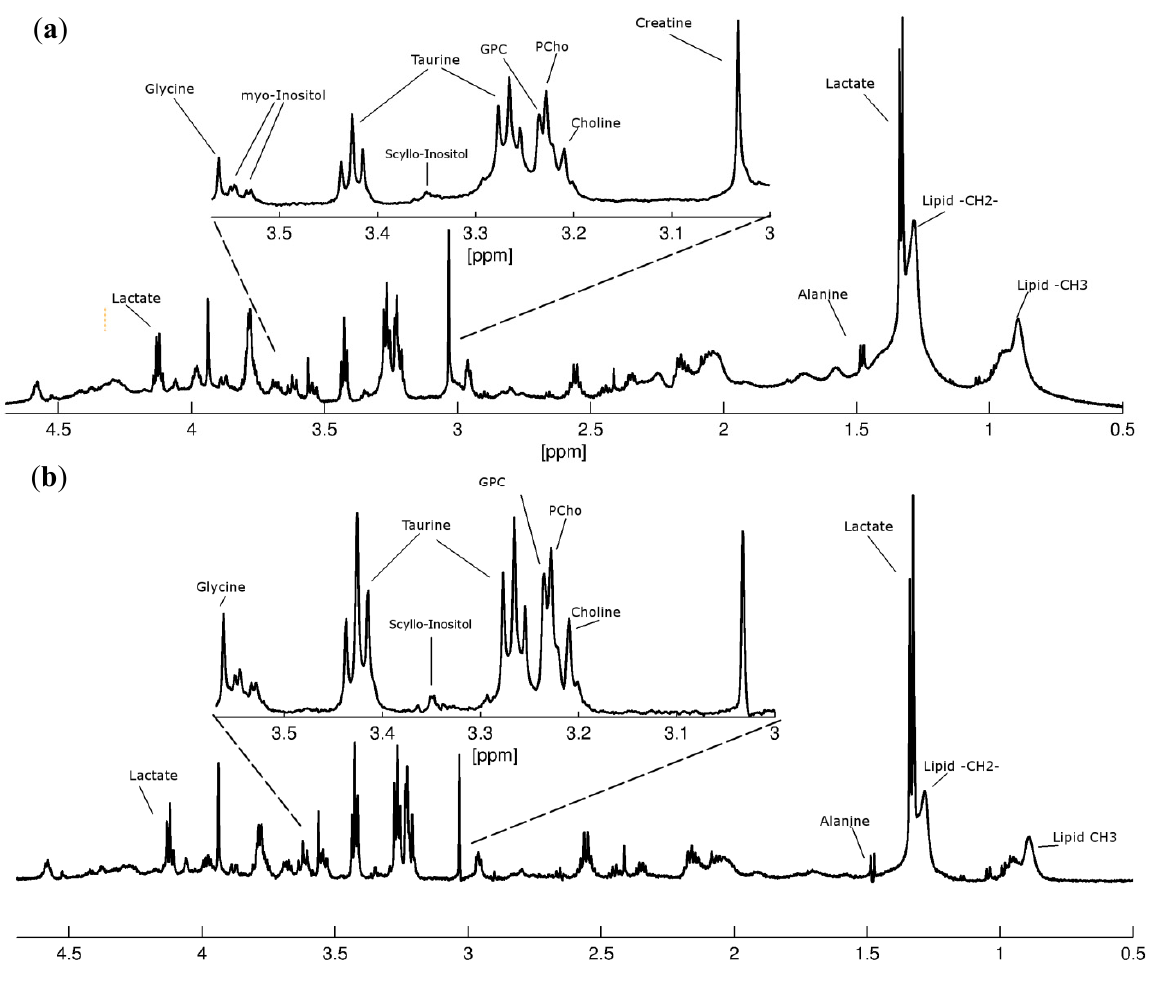
Figure 1. Representative proton HR-MAS spectra from a patient with brain metastasis from lung carcinoma obtained as ( a ) pre-saturated, single-pulse spectrum and ( b ) spin-echo spectrum, showing assignment of various metabolites. The enlarged ppm region 3.6–3.0 ppm shows more details of glycine (Gly), myo-inositol (myo-In), taurine (Tau), scyllo-inositol (scy-In), glycerophosphocholine (GPC), phosphocholine (PCho), choline (Cho) and creatine